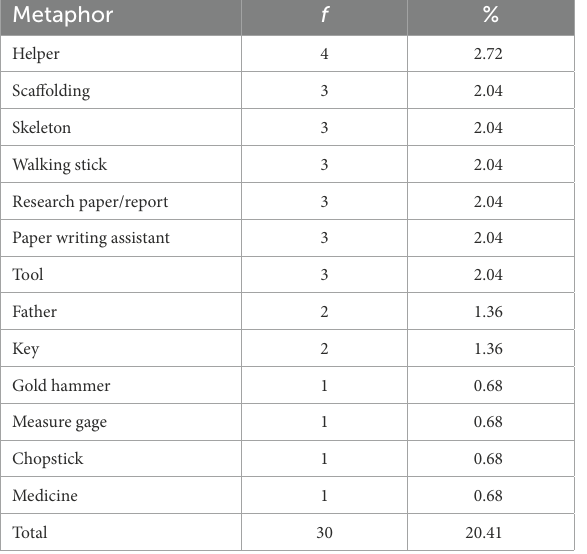
TABLE 3 Frequency and percentage of the textbook metaphor in the conceptual category of “grit.” Metaphor